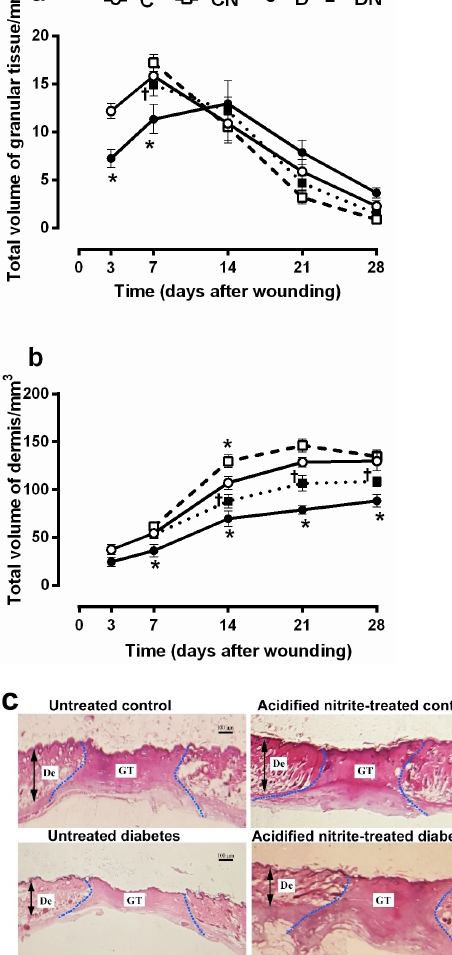
Figure 3. Effect of the topical acidified nitrite application on the total volume of the granular tissue ( a ) and the total volume of the dermis ( b ). Representative images of H&E-stained sections at day 7 after wounding (100× magnification and scale bar = 100 μ m) ( c ). Dotted lines indicate the border between the granular tissue and dermis. GT, granular tissue; De, Dermis; C, untreated control; CN, acidified nitrite-treated control; D, untreated diabetes; and DN, acidified nitrite-treated diabe- tes. * p < 0.05 compared to untreated control rats, and † p < 0.05 compared to untreated diabetic rats. Values are mean ± SEM, n = 6/subgroup.